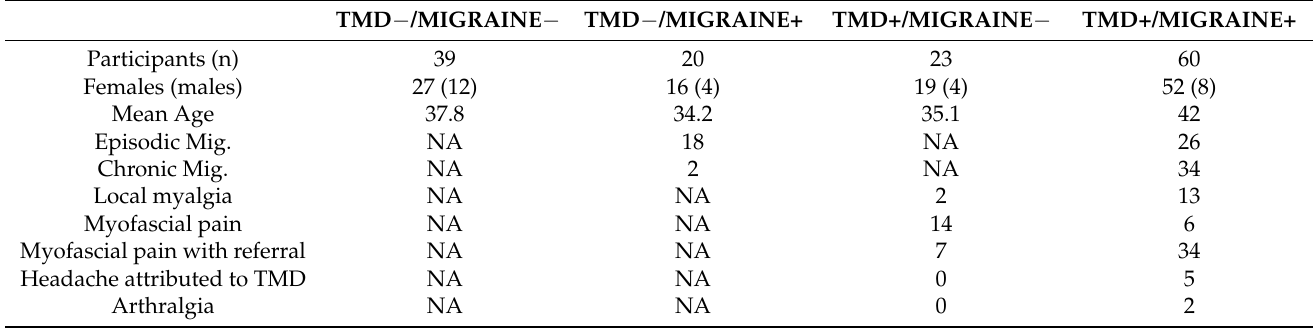
Table 1. Sample characteristics depending on the group.